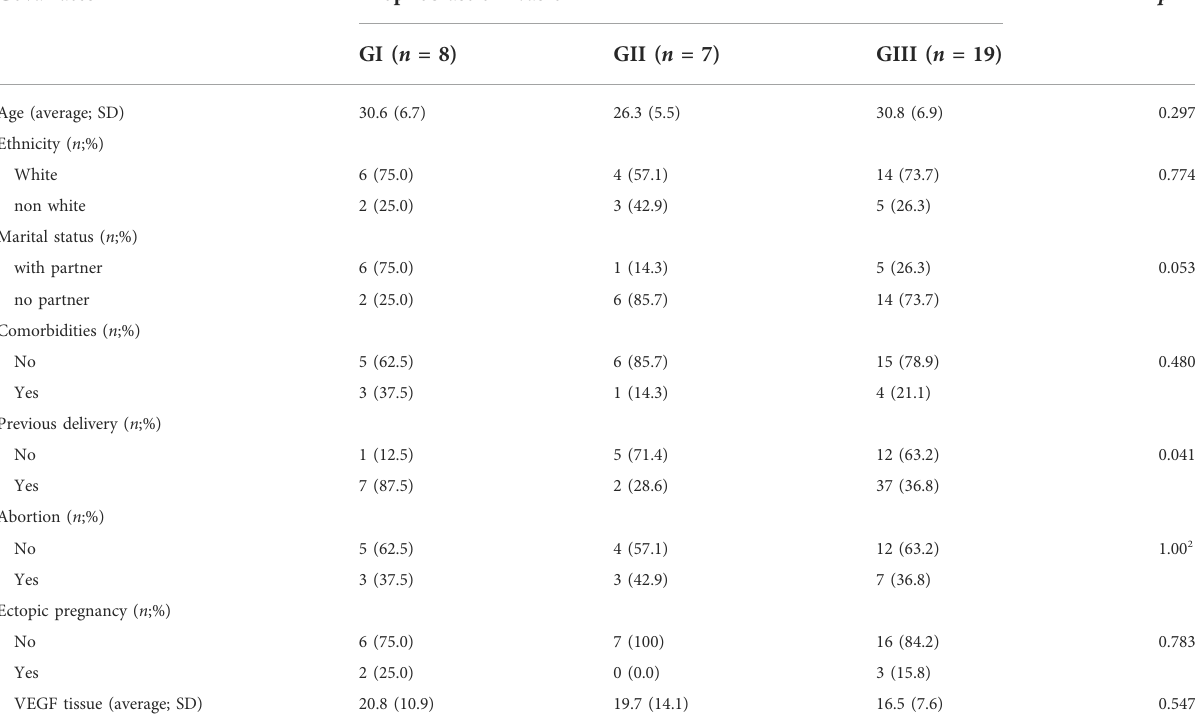
TABLE 1 Sociodemographic and clinical characteristics of patients associated to Trophoplastic invasion.